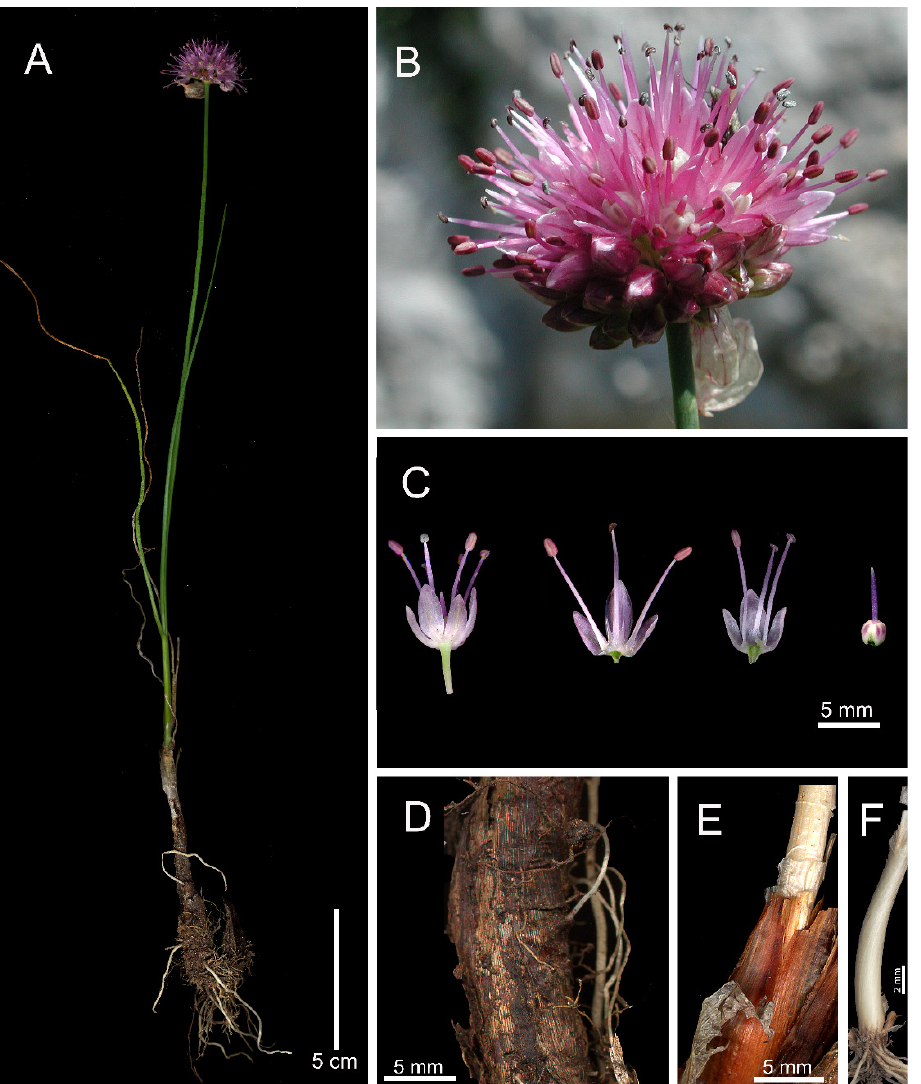
Figure 1. Allium ducissae. ( A ) Habit. ( B ) Inflorescence (Murolungo, Duchessa mountains, Abruzzo, Italy; photo by M. Iocchi). ( C ) Flowers, tepal and filament arrangement, pistil. ( D ) Outer bulb tunic. ( E ) Inner bulb tunic. ( F ) Bulb inserted on a short rhizome.